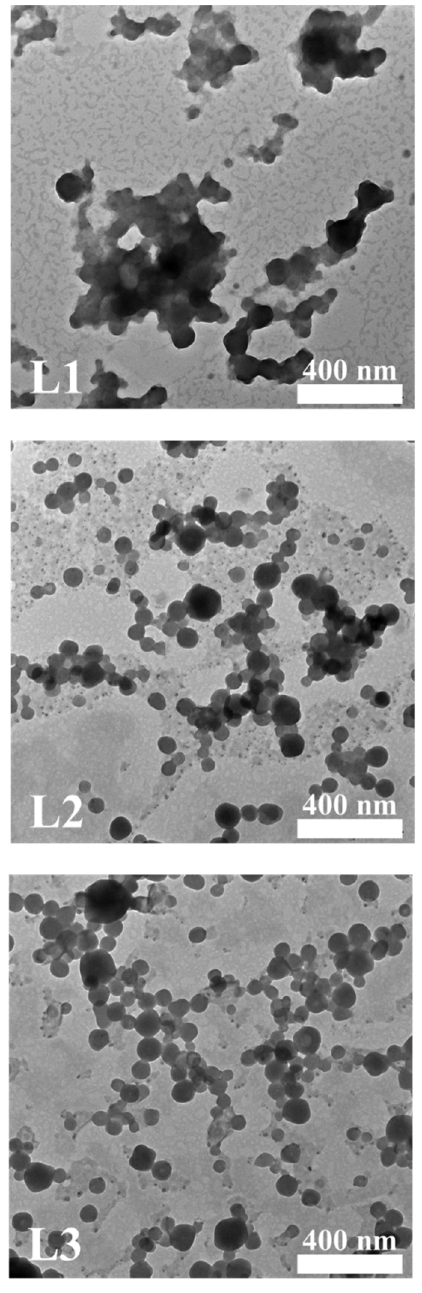
Figure 4. TEM images of diluted lidocaine ointments (magnification: ×20,000, scale bar: 400 nm). TEM: transmission electron microscope. TEM: transmission electron